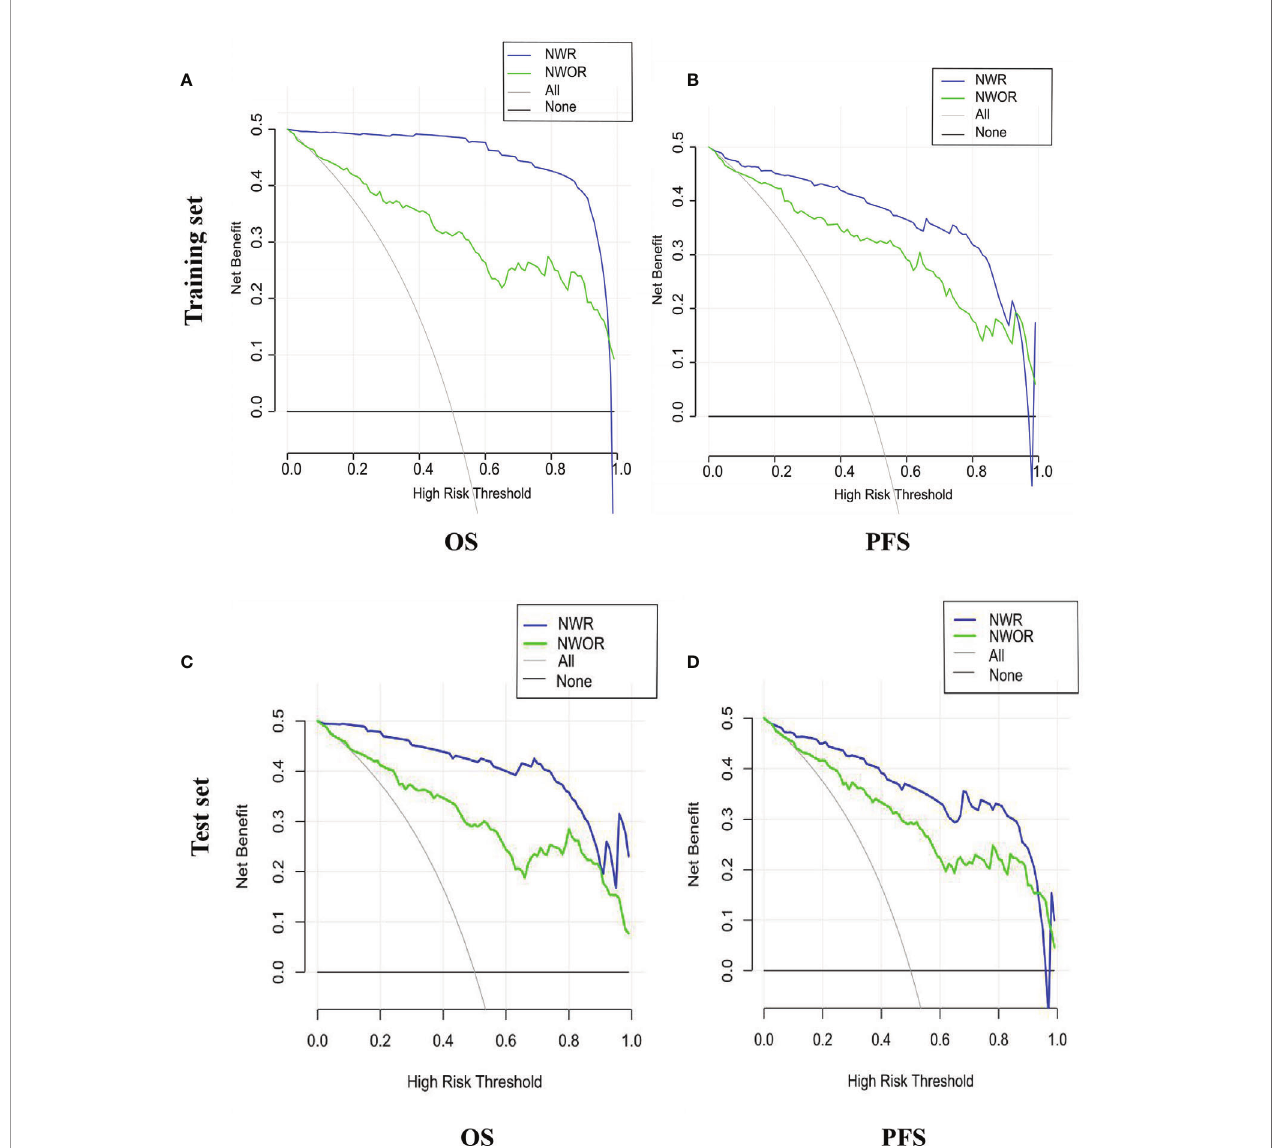
FIGURE 5 | Decision curve of the nomograms for OS (A) and PFS (B) in the training set. Decision curve of the nomograms for OS (C) and PFS (D) in the test